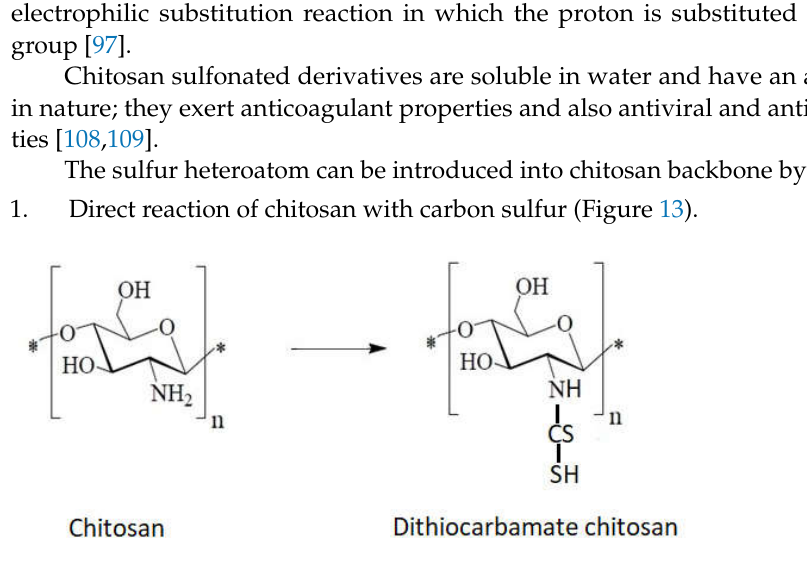
Figure 13. Schematic reaction of chitosan with carbon sulfur. Chemically modified chitosan, by incorporating functional groups of dithiocarbamate,